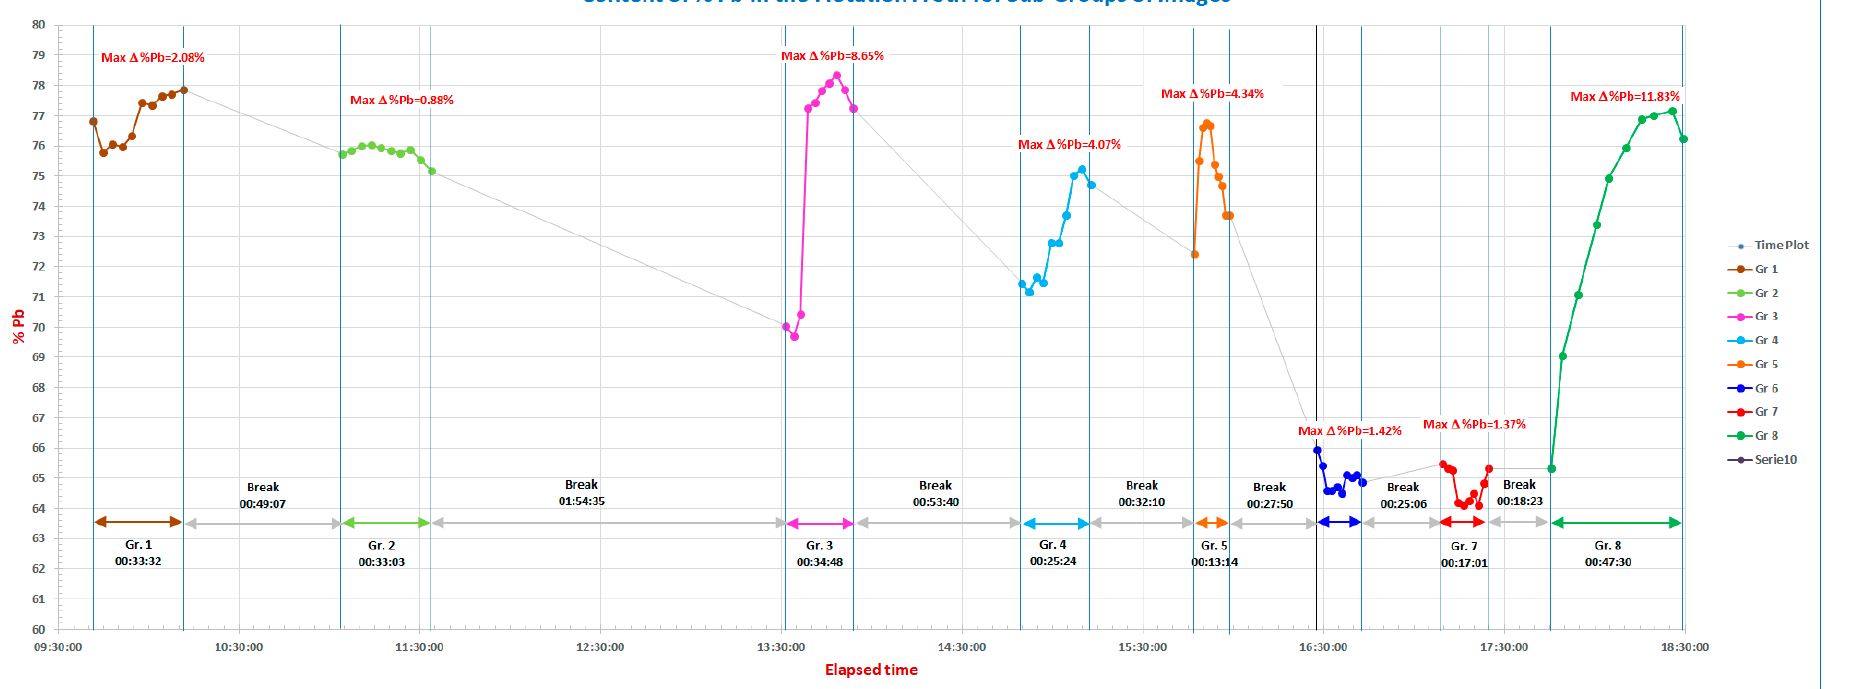
Figure 2. Content of %Pb in the flotation froth versus time during the experiment.